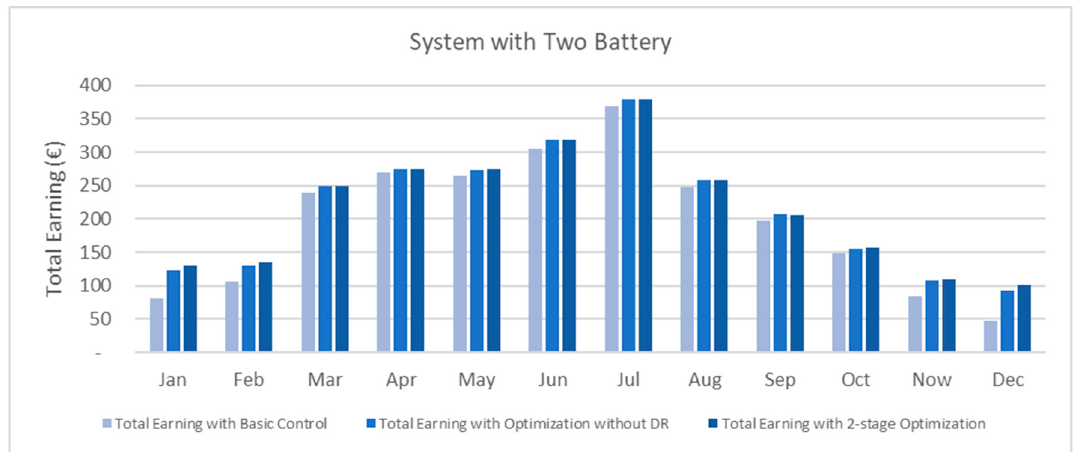
Figure 17. Methodology comparison for a one-battery case.